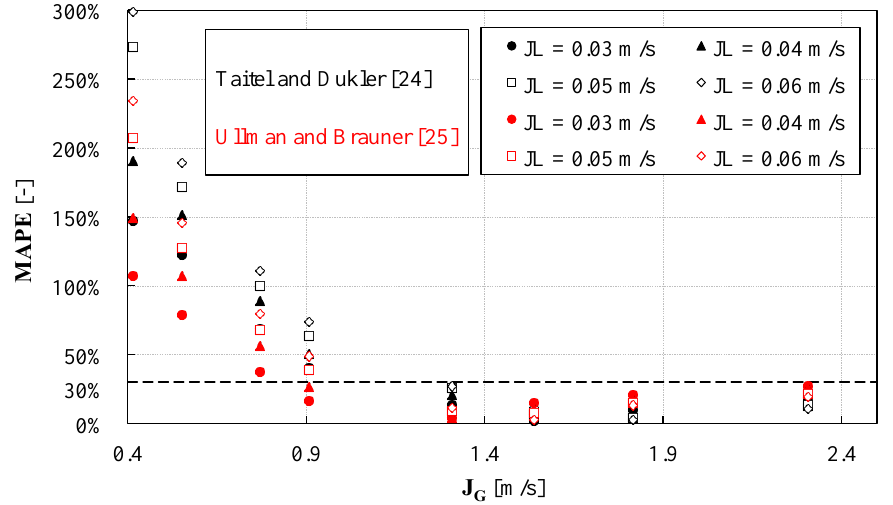
Figure 7. Two-fluid model momentum balance on a pipe element of length dx.